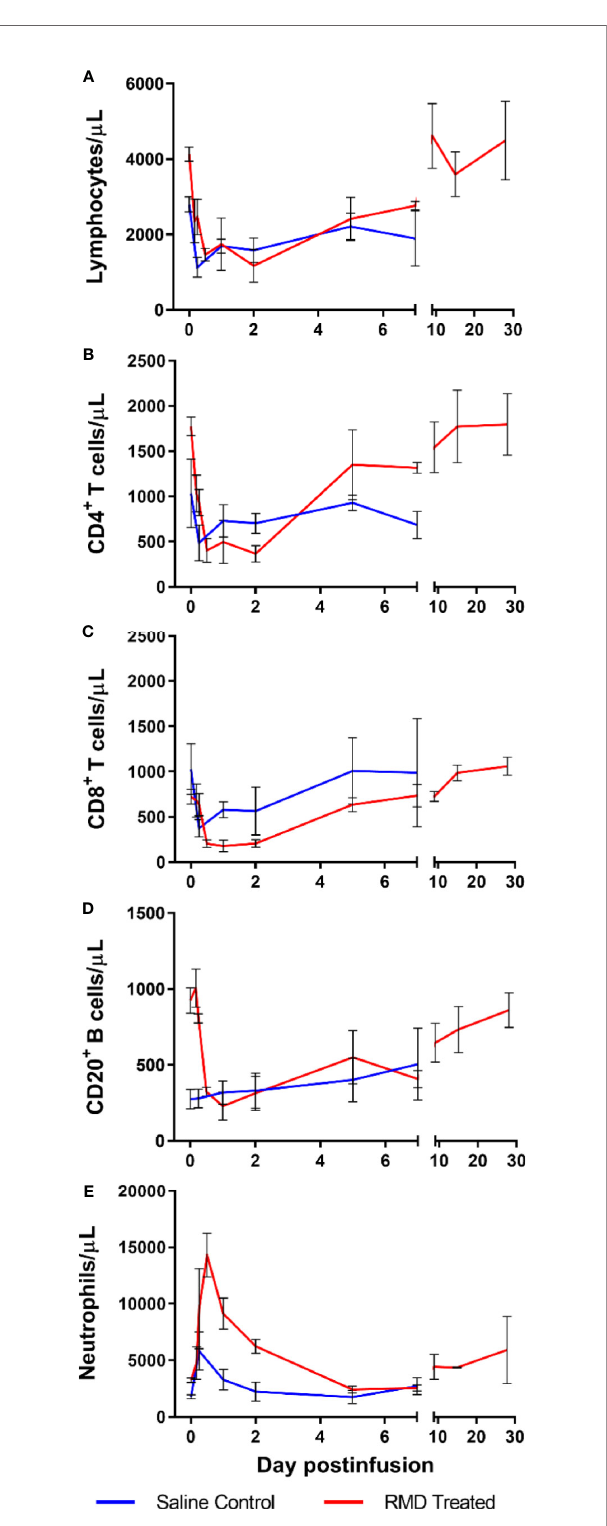
FIGURE 5 | Immune cell populations in 3 SIV-naïve RMs treated with 7 mg/ m 2 RMD via 4-h infusion vs. 3 saline-treated controls. Total lymphocyte counts (A) , absolute counts of CD4 + (B) and CD8 + (C) T cells, CD3 − CD20 + B cells (D) , and segmented neutrophils (E) from